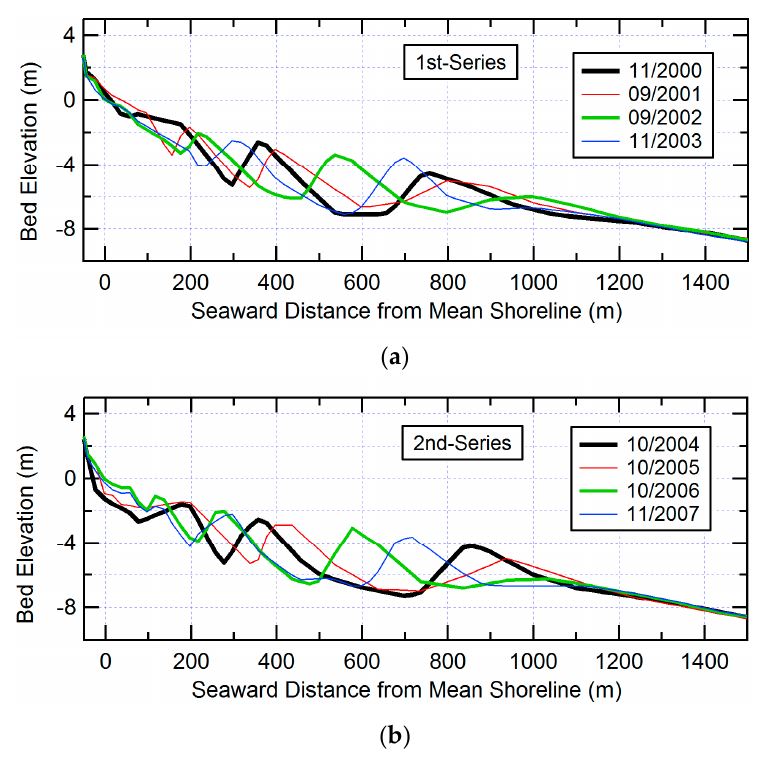
Figure 10. Example of the cyclic migration of sandbars (line H40).